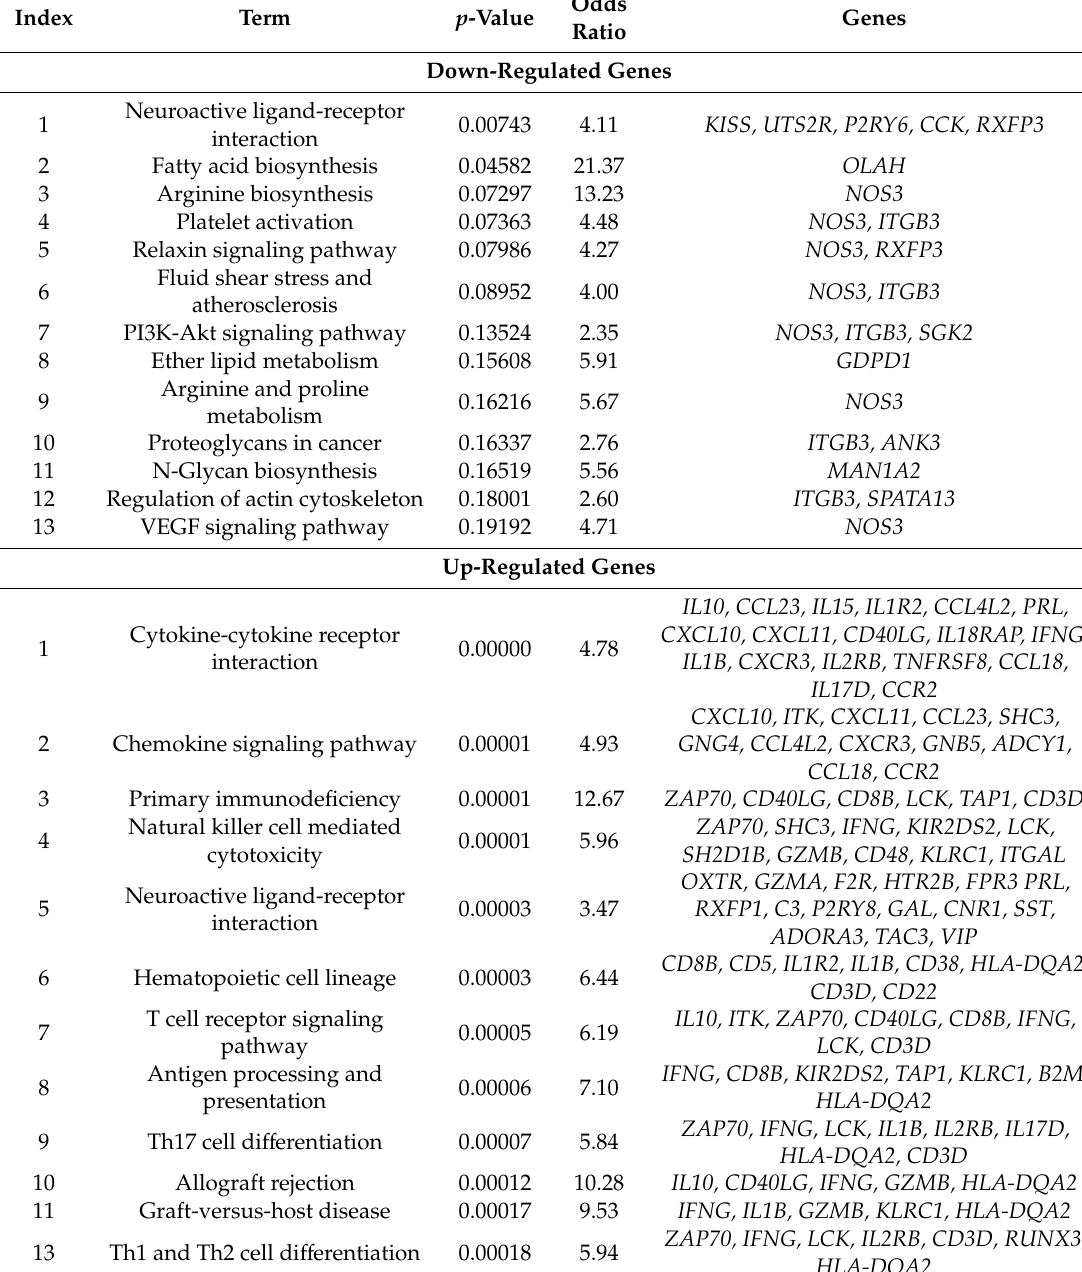
Table 2. Top Enrich terms of di ff erentially expressed genes in